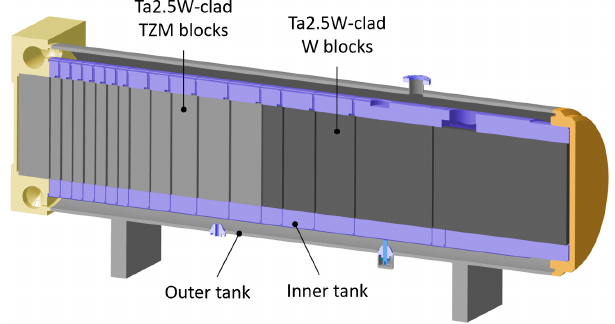
FIG. 1. Current design of the BDF target assembly, as described in Ref. [5]. The target core materials (TZM and W) clad with a thin layer of Ta2.5W can be seen, as well as the two concentric tanks supporting the core and enclosing the target cooling system.